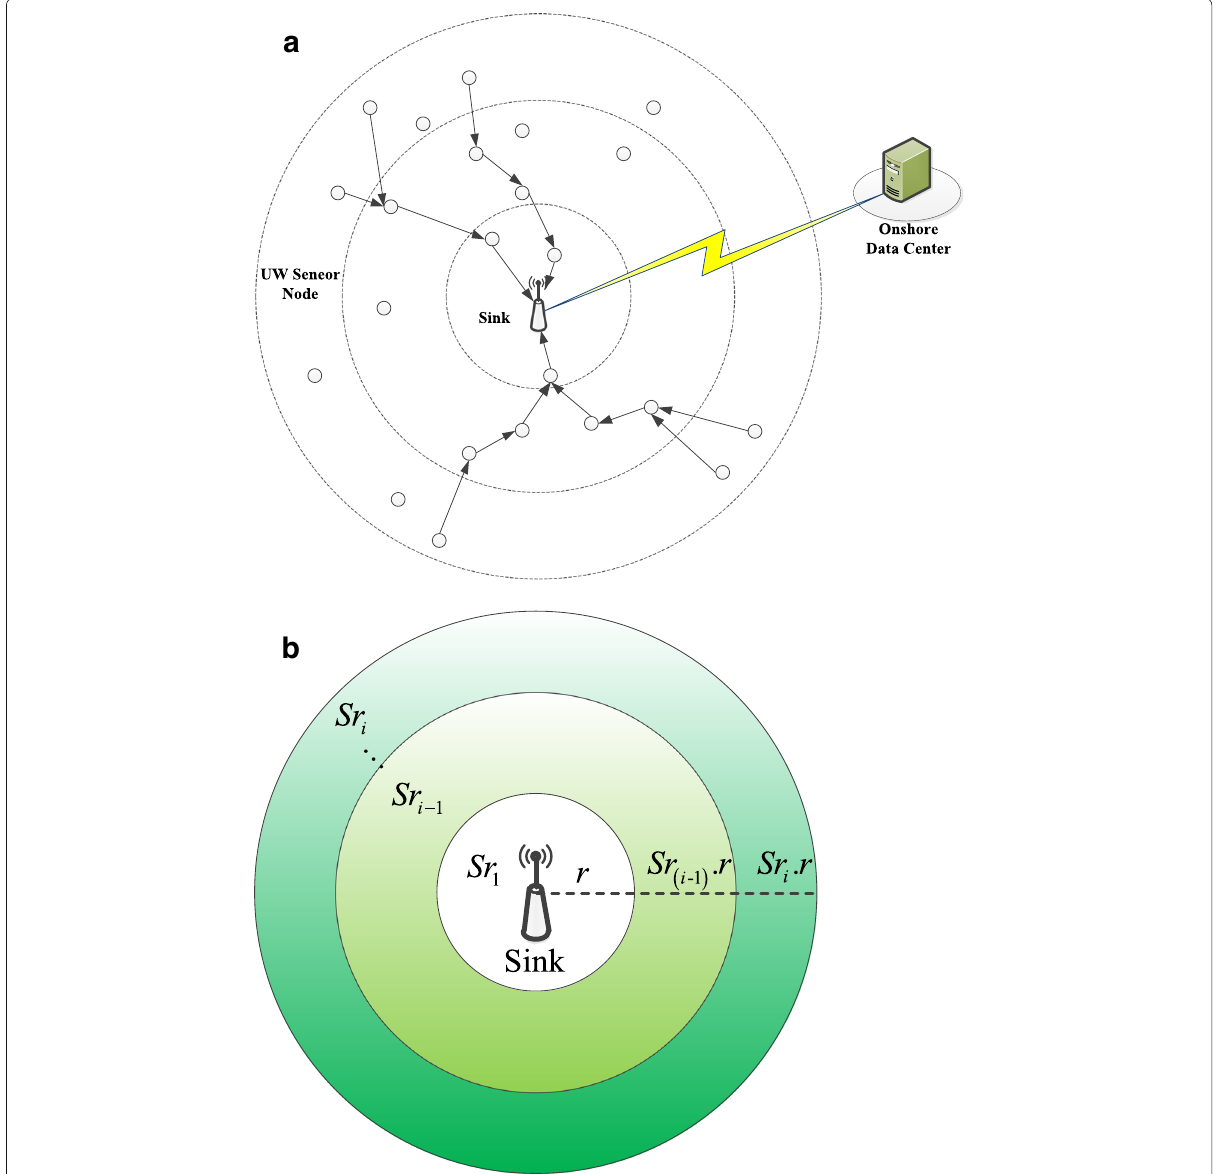
Fig. 2 The structure of UWSN. a Network topology. b Ring sector. Sink is on the center to gather data from other nodes and transmits them to data center. All nodes are located in ring sections ( Sr ) randomly and the radius of each section is r